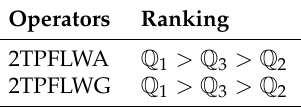
Table 4. Ranking of the alternatives.